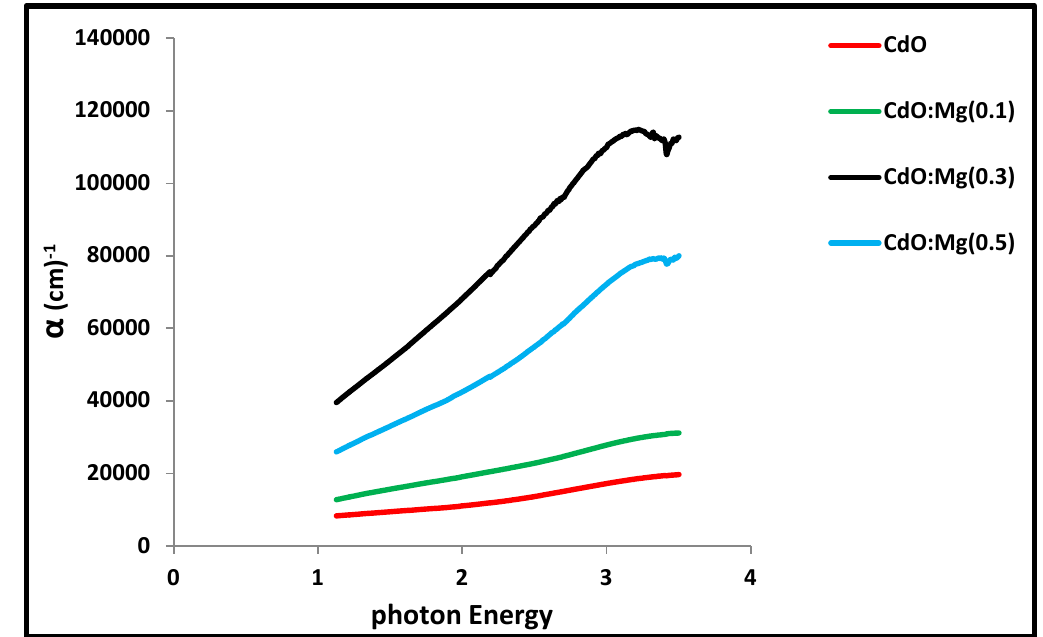
Fig.5: Change of absorption coefficient with photon energy for a pure CdO-magnesium- impregnated